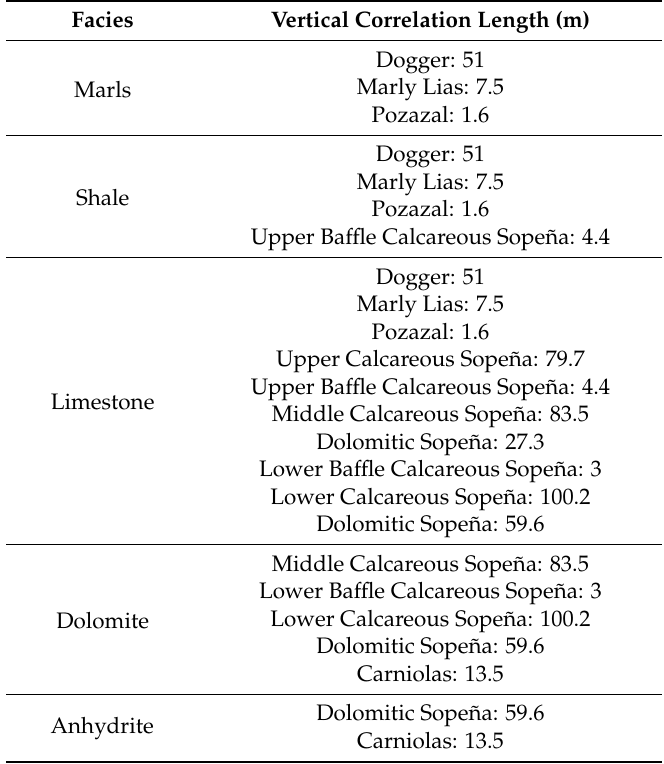
Table 1. Matrix facies characteristics for the different formations in the storage complex model.